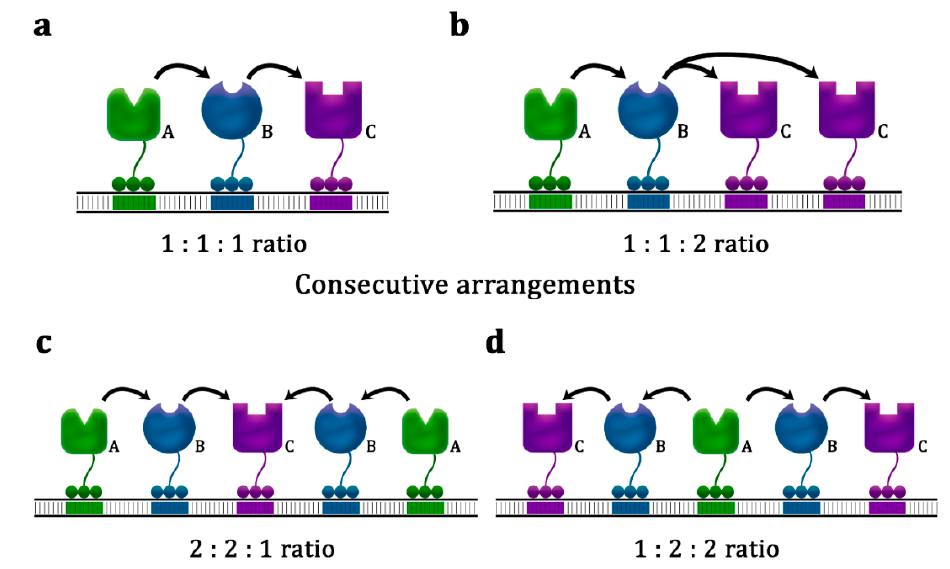
Figure 4. Examples of various DNA scaffold architectures. ( a , b ) Consecutive arrangement, where enzymes are arranged linearly in a [1:1:1] ( a ) and [1:1:2] ratio ( b ). ( c , d ) Bidirectional arrangement, where the third enzyme (C) is flanked on both sides by the second (B) and then the first (A) enzymes in a [2:2:1] ratio ( c ) or where the first enzyme (A) is flanked on both sides by the second (B) and then the third (C) enzymes in a [1:2:2] ratio ( d ).